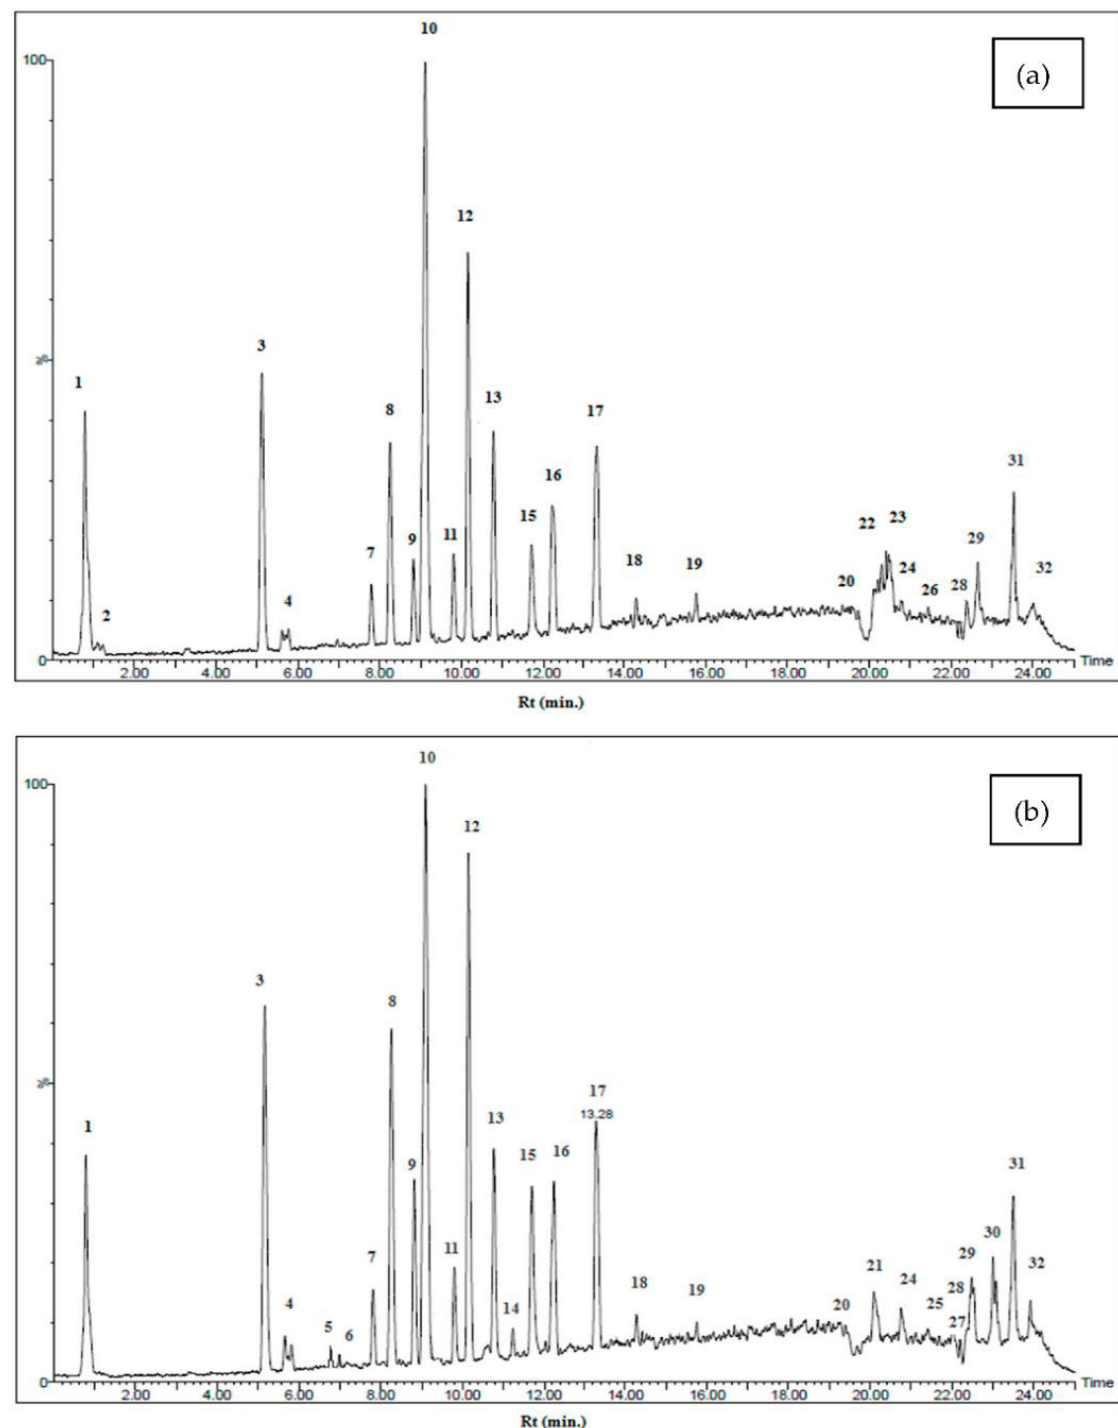
Figure 1. UPLC-ESI-MS/MS chromatograms in negative ion ionization mode of the ethanol extracts of E. africanus . ( a ) F 1 S 0 : Control plants normally irrigated (100% FC). ( b ) F 4 S 3 : plants irrigated with 25% FC and sprayed using 3 mM SA. Numbers in the chromatograms denote peak numbers on